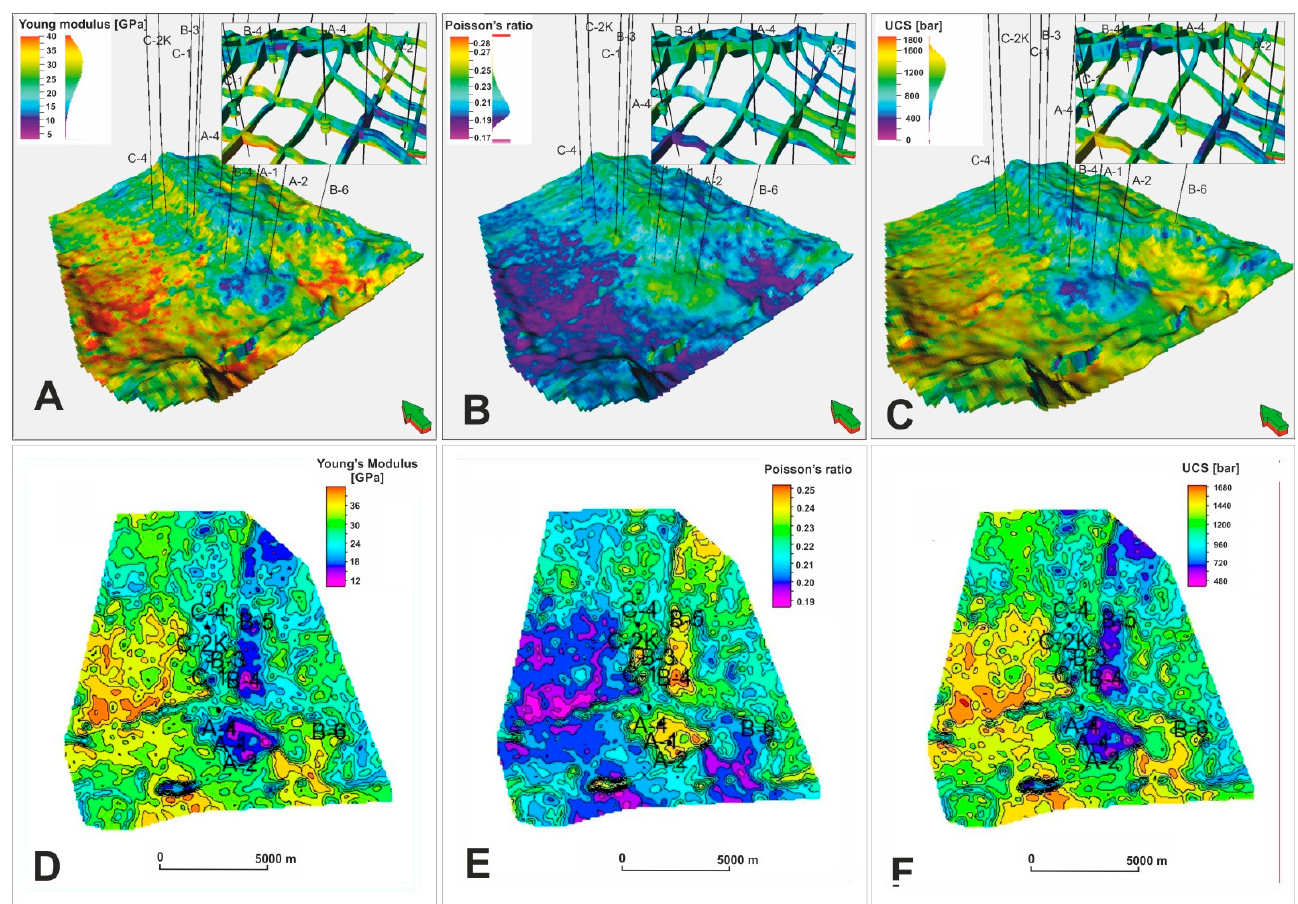
Figure 7. Visualisation of 3D distribution of ( A ) Young’s modulus, ( B ) Poisson’s ratio, and ( C ) unconfined compressive strength (UCS), and the average values of the ( D ) Young’s modulus, ( E ) Poisson’s ratio, and ( F ) UCS.